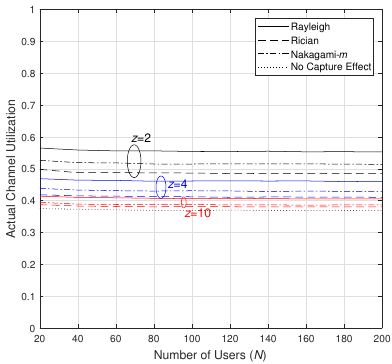
Figure 6. Actual channel utilization when z =